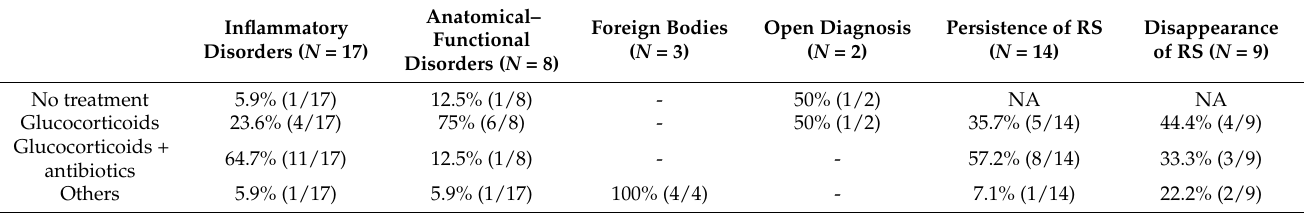
Table 3. Comparison by therapeutic subgroups of main diagnosis of reverse sneezing (RS) and persistence after